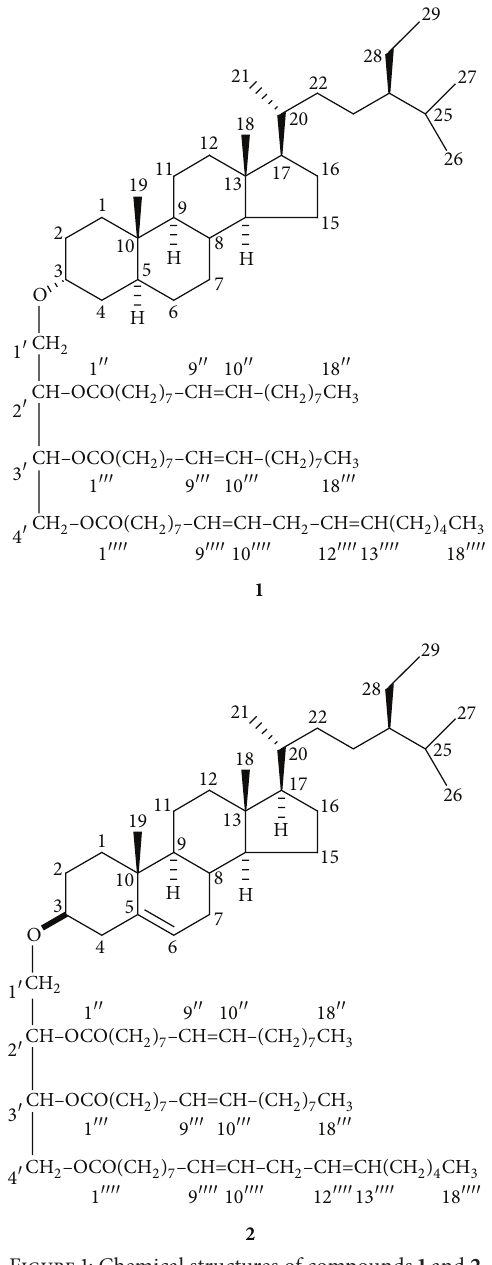
Figure 1: Chemical structures of compounds 1 and 2 .